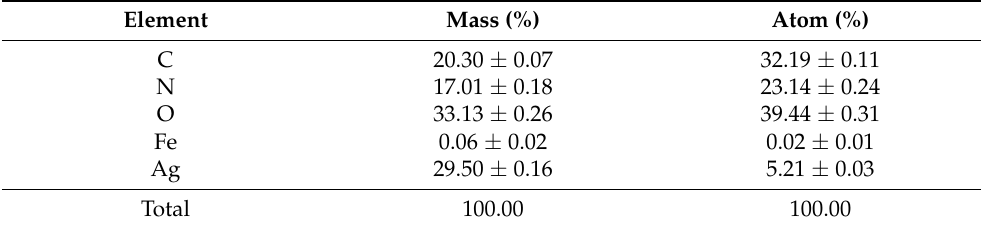
Figure 2. Results of EDX Mapping-SEM conjugation Fe 3 O 4 @Chitosan-AgNPs. Table 1. Percentage of connotation elements Fe 3 O 4 @Chitosan-AgNPs (0.4).